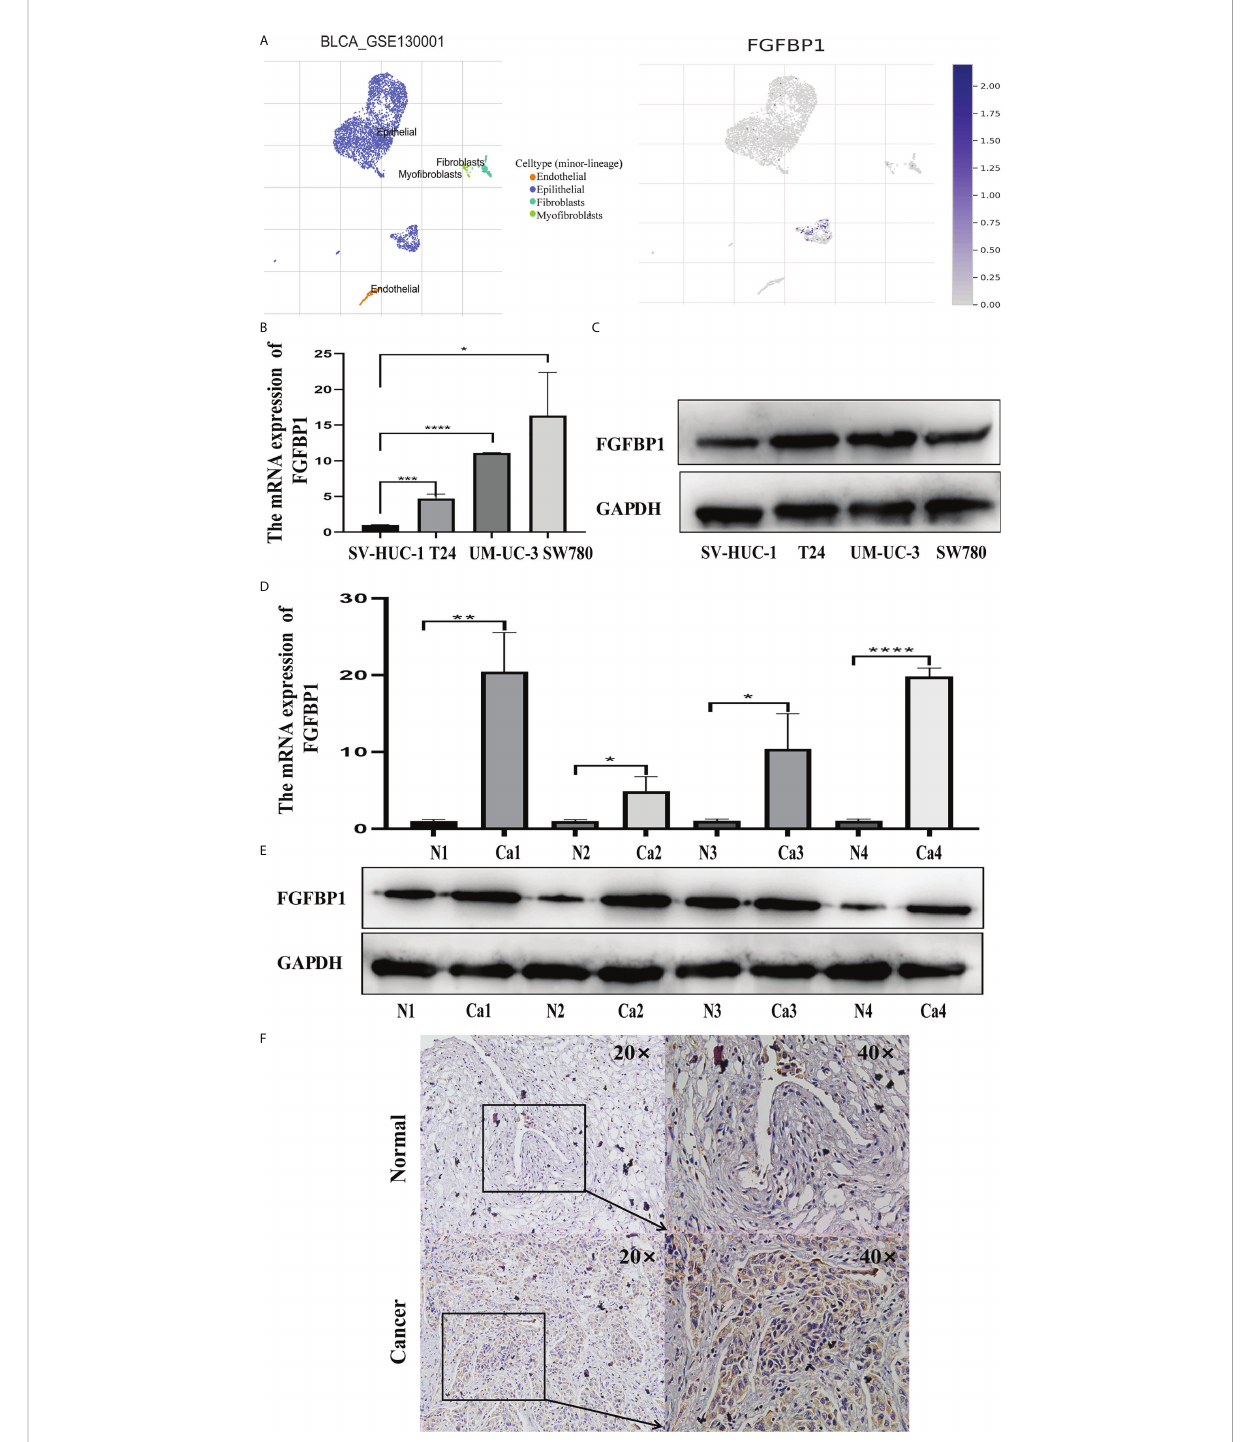
FIGURE 5 Increased FGFBP1 is veri fi ed in BCa. (A) Expression of FGFBP1 at the single-cell level in BCa using the TISCH database. Each dot corresponds to a single cell and is colored according to the cell cluster. The color density indicated the expression of FGFBP1. (B) FGFBP1 was veri fi ed in BCa cell lines by RT-qPCR. (C) FGFBP1 was veri fi ed in BCa cell lines by Western blotting. (D) FGFBP1 was veri fi ed in BCa tissues by RT-qPCR. (E) FGFBP1 was veri fi ed in BCa tissues by Western blotting. (F) Elevated FGFBP1 was observed in BCa tissues by immunohistochemistry staining. * p < 0.05; ** p < 0.01; *** p < 0.001, **** p <